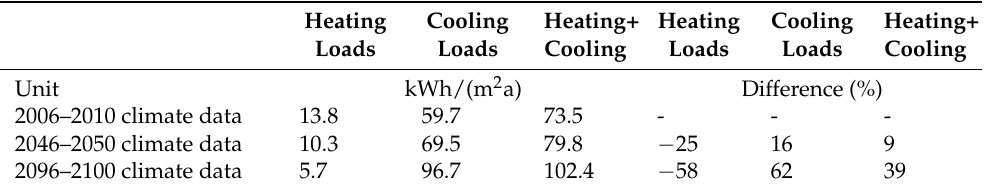
Figure 7. Whole-building heating and cooling loads — cooling and heating season. Table 4. Simulation results—heating and cooling loads.